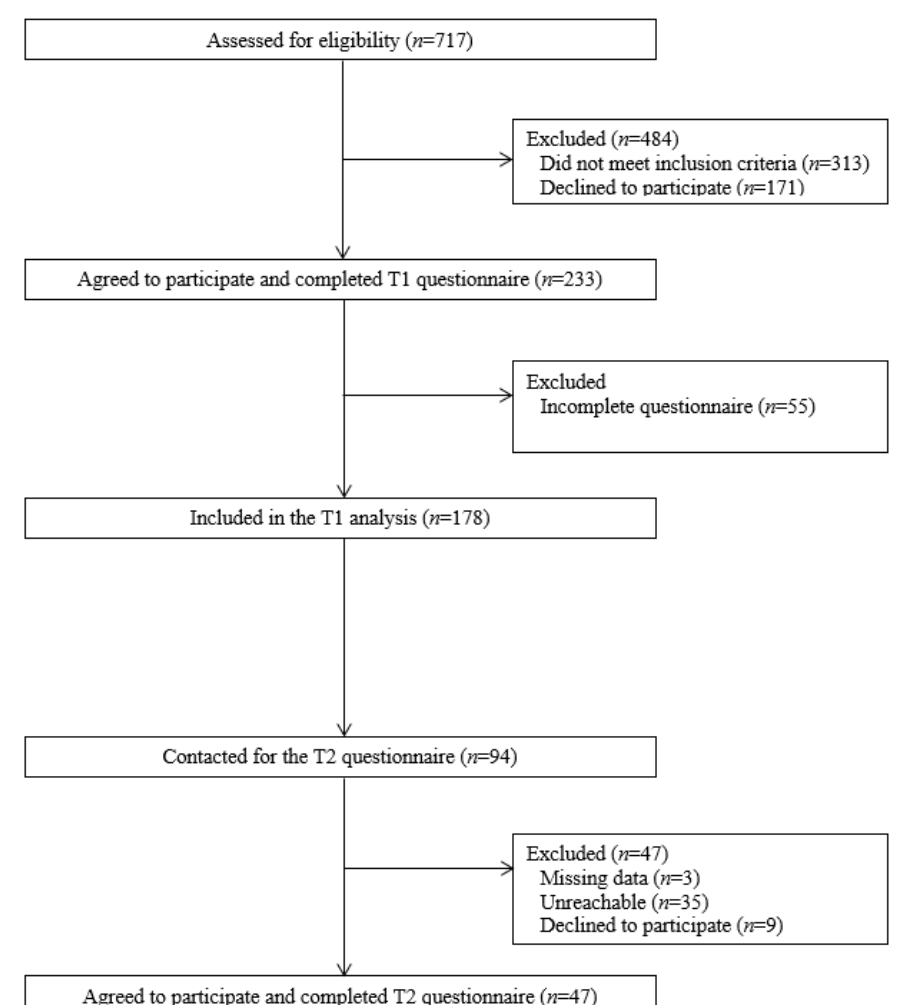
Figure 1. Flow chart of the